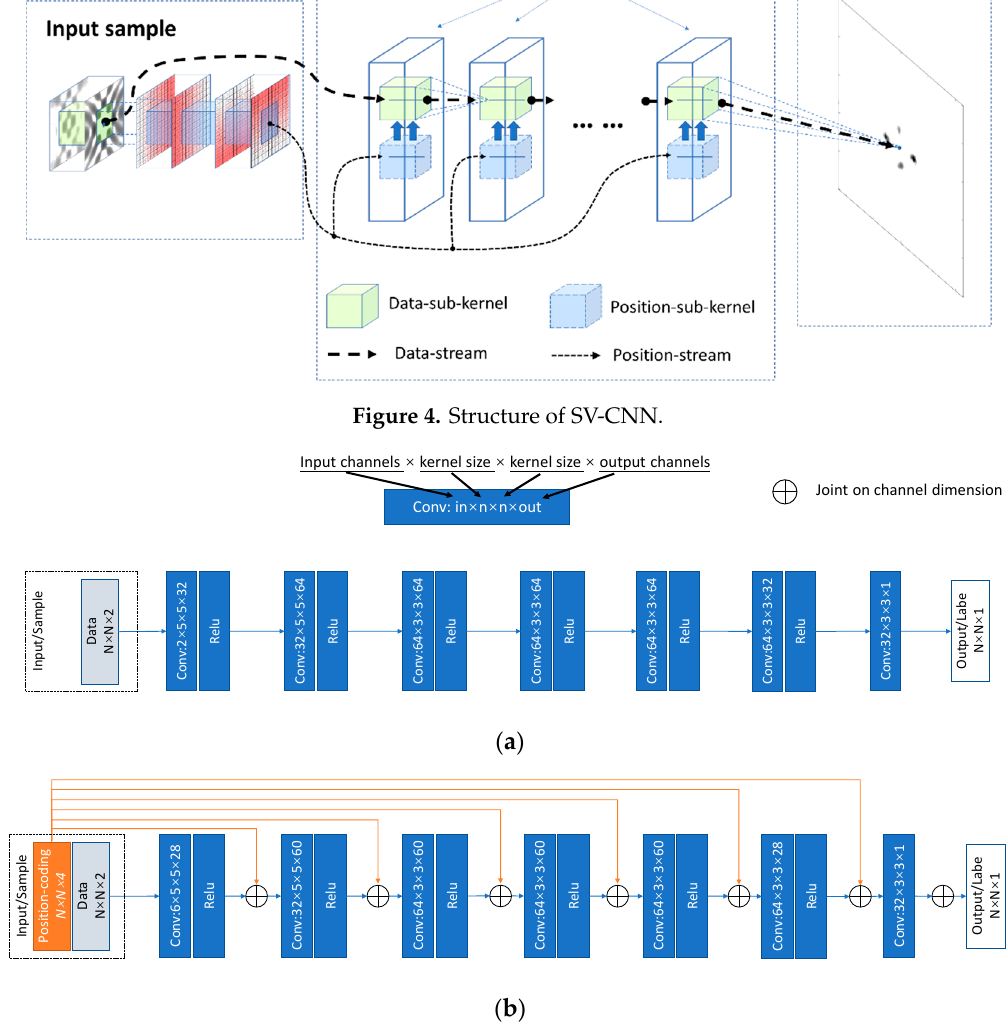
Figure 5. Structure and parameters of ( a ) CNN; ( b ) SV-CNN.